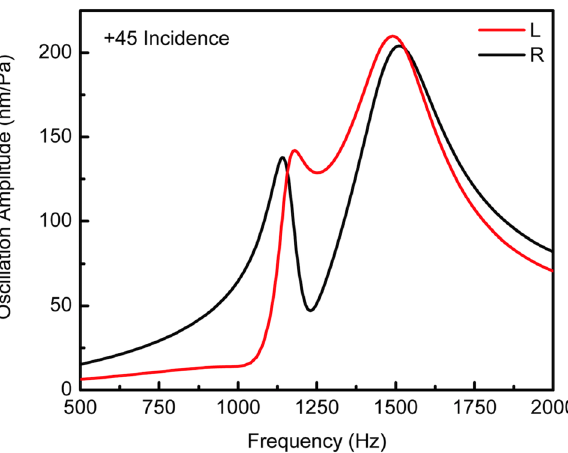
Figure 4. Simulated mechanical frequency response. Finite-element method simulation for sensor under similar acoustic excitation used in the vibrometer measurement (+ 45° oblique incidence). A small slit added to the cavity backplate modeled the air and pressure exchange of an imperfectly closed back cavity with the exterior medium. By controlling the slit size, it was possible to tune the bending mode contribution to the resulting wing oscillation amplitude, until it was deemed close enough to the measurement in Fig.